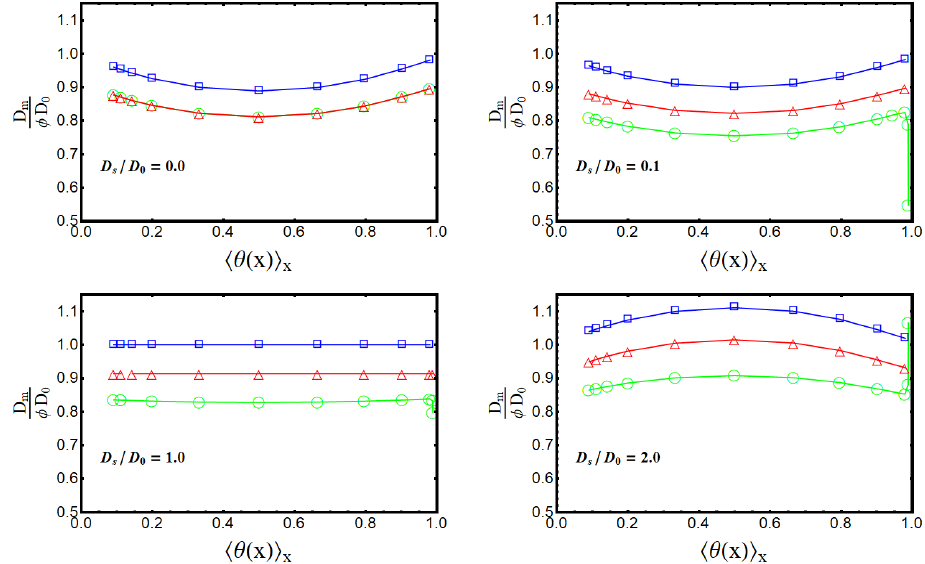
Figure 10. Effective diffusion coefficient of a membrane as a function of the loading for the three pores studied, and for several values of the surface diffusion coefficient. It is clear that the surface diffusion changes the concavity of the curve and, at fixed loading, increases the efficiency of the mass transport. See Appendix A for simulation